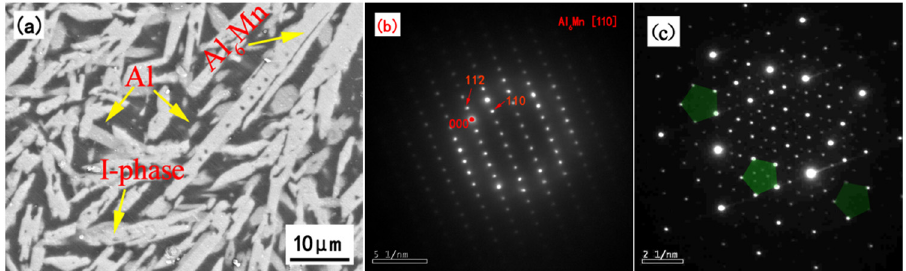
Figure 10: Microstructure of the Al – Mn – Fe alloy prepared by injection casting method: ( a ) SEM image; ( b and c ) corresponding SAED patterns of the Al 6 Mn phase and I - phase in ( a )